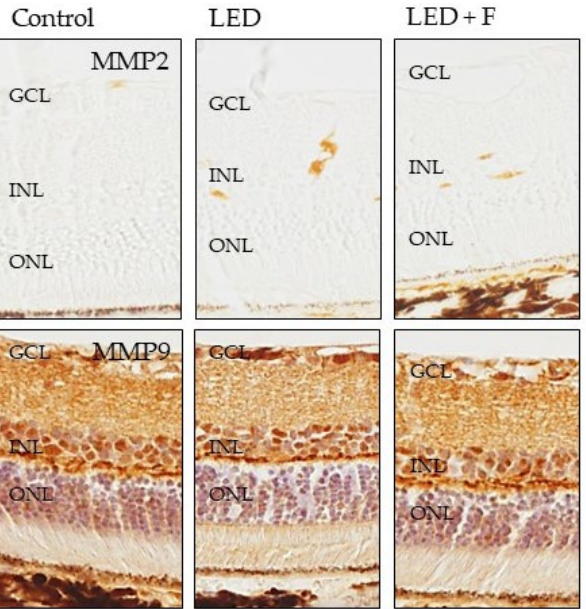
Figure 8. Immunohistochemical detection of MMP2 ( upper panel ), and MMP9 ( lower panel ) in the three groups of rats investigated. LED: animals exposed to LED-backlit screen for 3 months; LED + F: animals exposed to filtered LED-backlit screen for 3 months. GCL: ganglionic cells layer; INL: inner nuclear layer; ONL: outer nuclear layer.